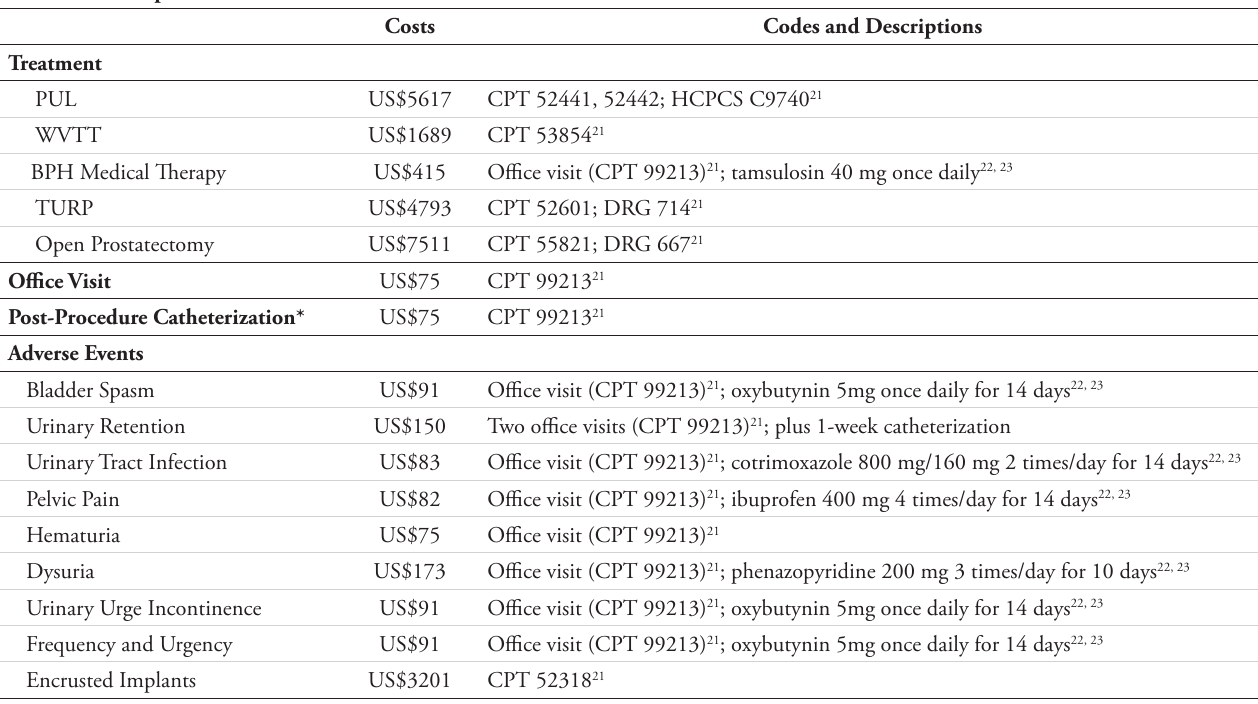
Table 2 . Cost Inputs